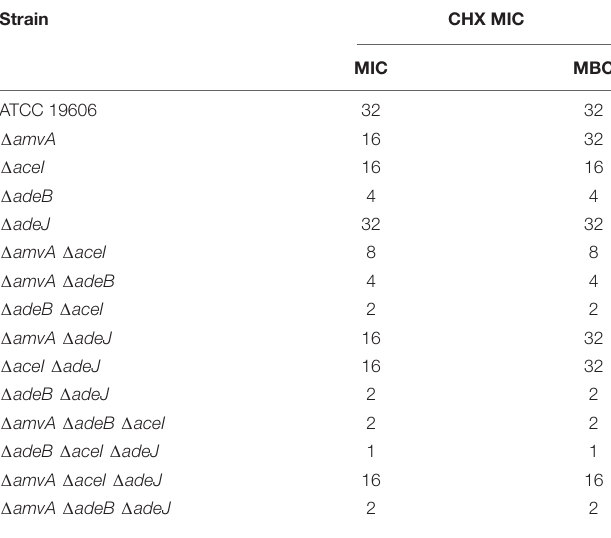
TABLE 2 | CHX MIC (mg/L) and MBC (mg/L) of A. baumannii ATCC 19606 parental strain and EP deletion mutants. Strain CHX MIC MIC